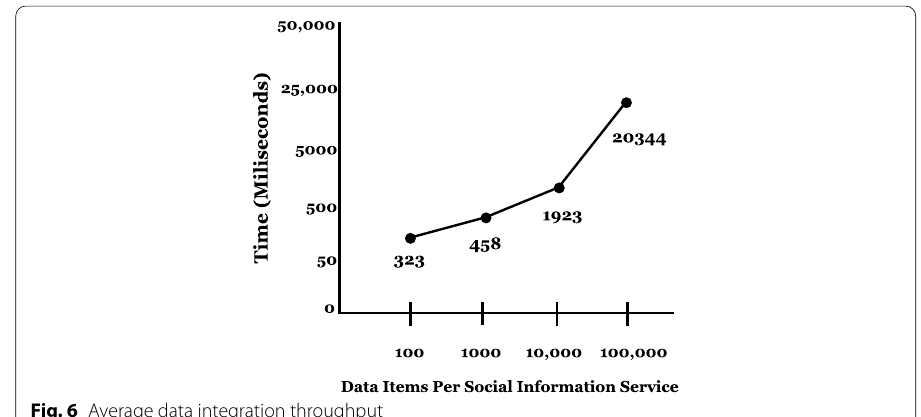
Fig. 6 Average data integration